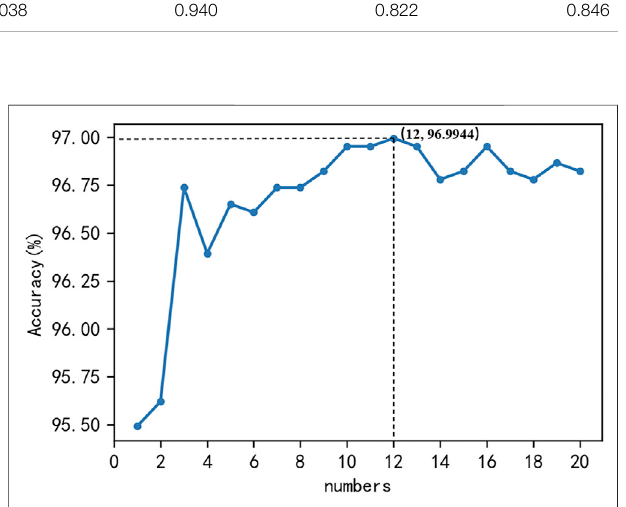
FIGURE 5 | The accuracy of hybrid features in predicting potential druggableproteins under theBagging-SVM classi fi cation algorithmwhere the number of base models was 1 –